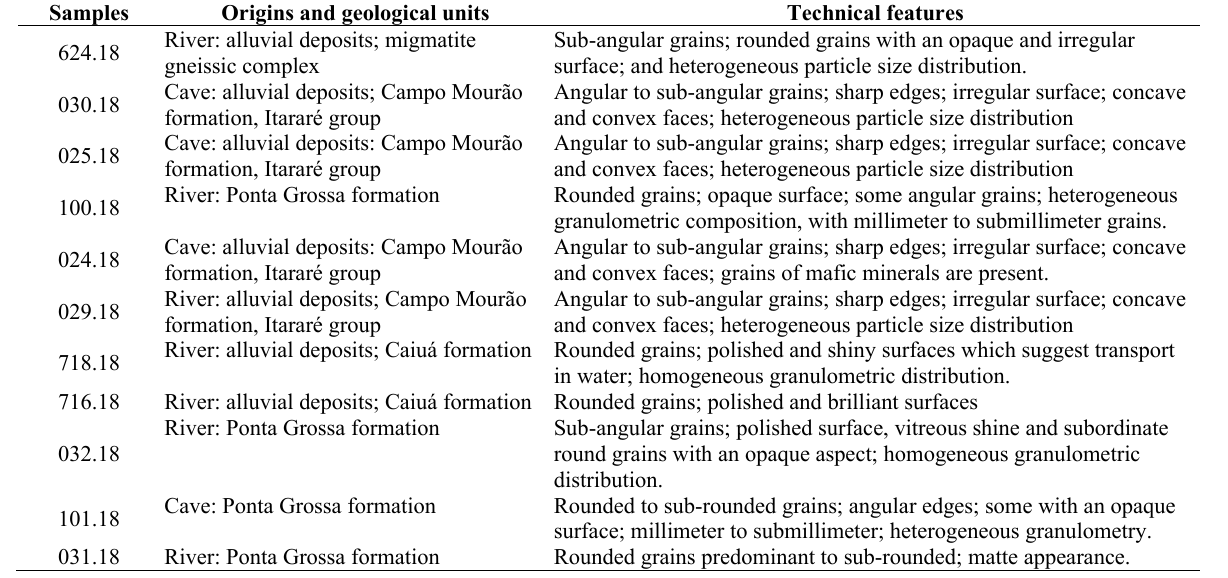
Table 1. Geotechnical characteristics of the sands collected and analyzed for ASR potential reactivity [23]–[27].